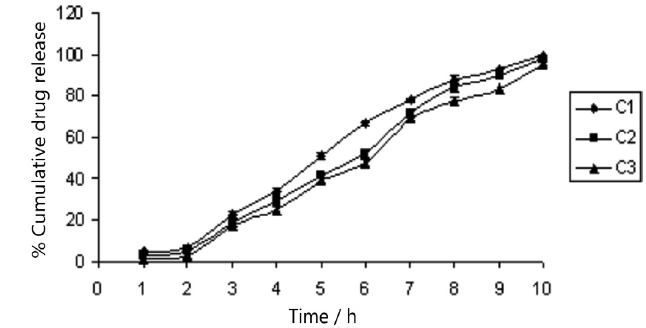
FIGURE 7 - Plot of % cumulative drug release vs. time (in hours). Data expressed as mean ± standard deviation